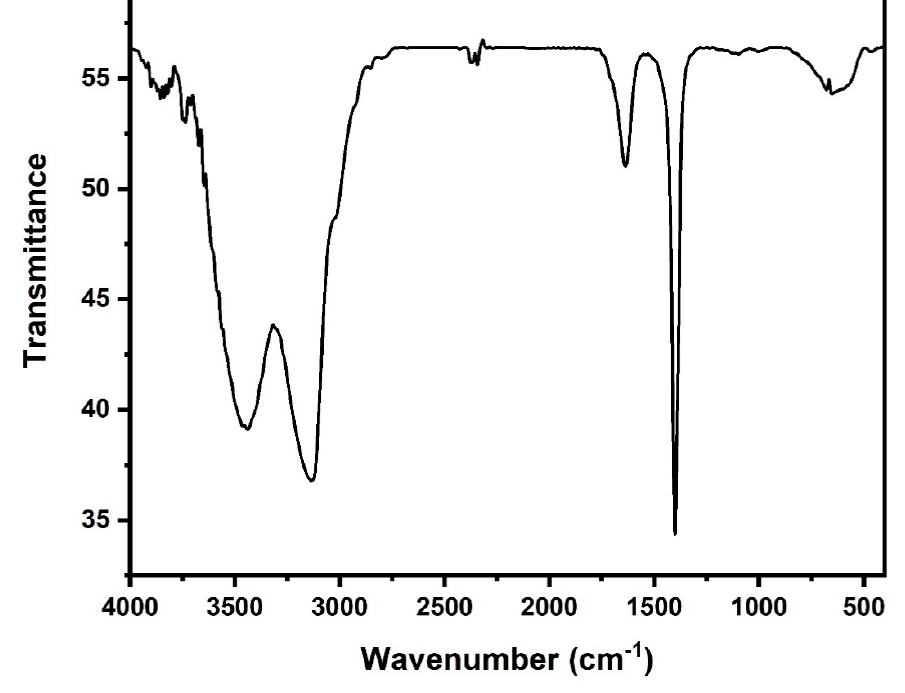
Figure 1. FTIR spectra of akaganeite.